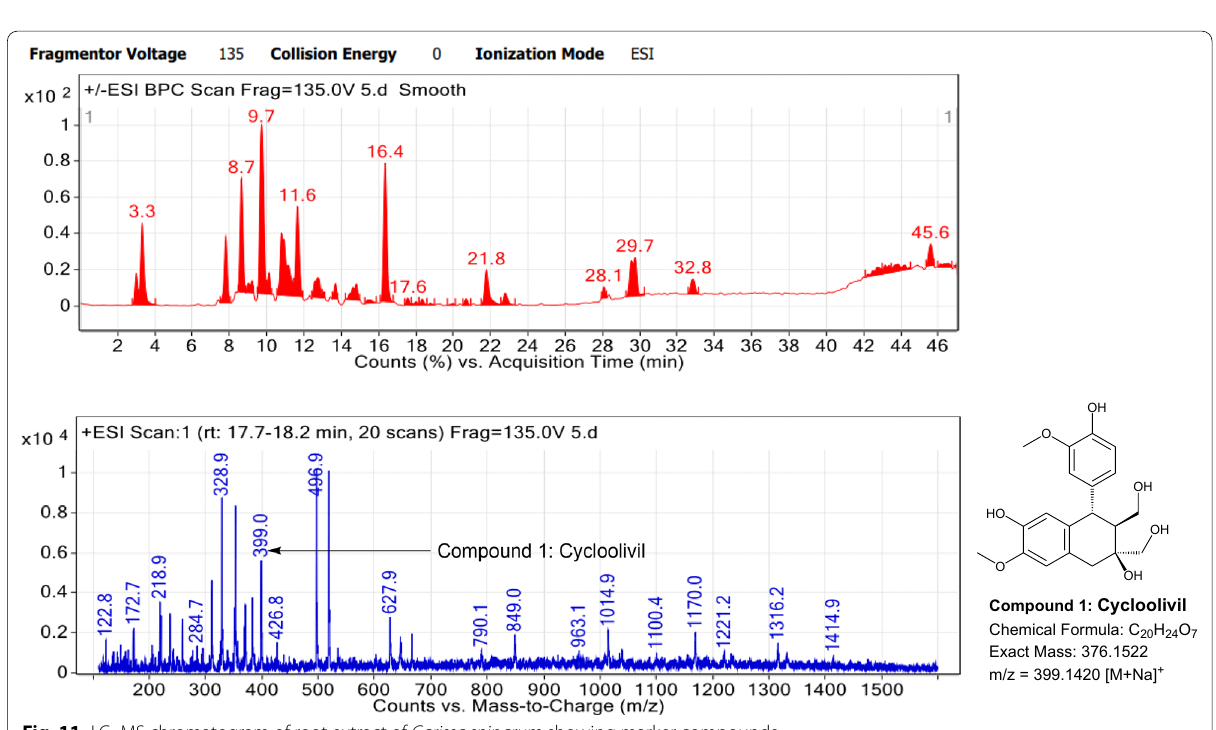
Fig. 11 LC–MS chromatogram of root extract of Carissa spinarum showing marker